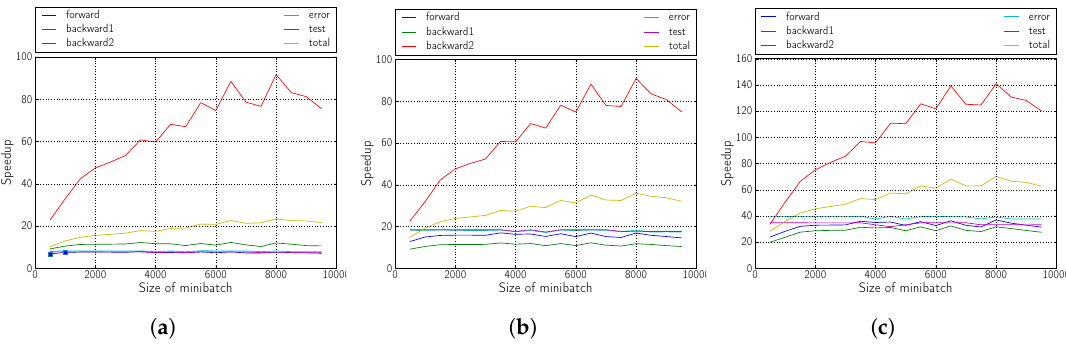
Figure 8. Speedup of kernel when varying when varying the mini-batch size. ( a ) Version 1; ( b ) Version 2; ( c ) Version 3.